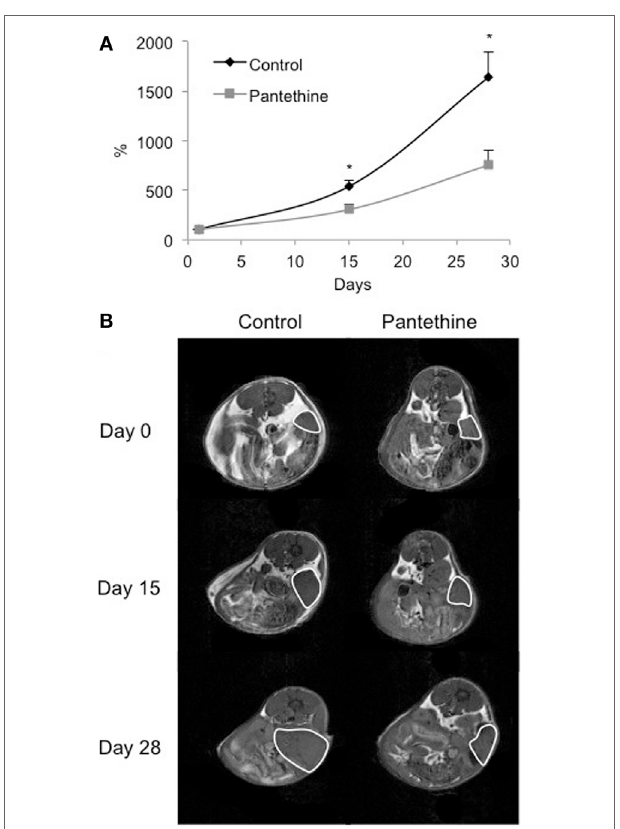
FigUre 2 | normalized tumor growth curves from control mice and pantethine-treated mice (a) and representative T 1 -weighted images of a central slice of tumors imaged at days 0, 15, and 28 of a control mouse (left column) and a treated mouse (right column) (b) . n = 13 and 14, respectively; * P < 0.05.